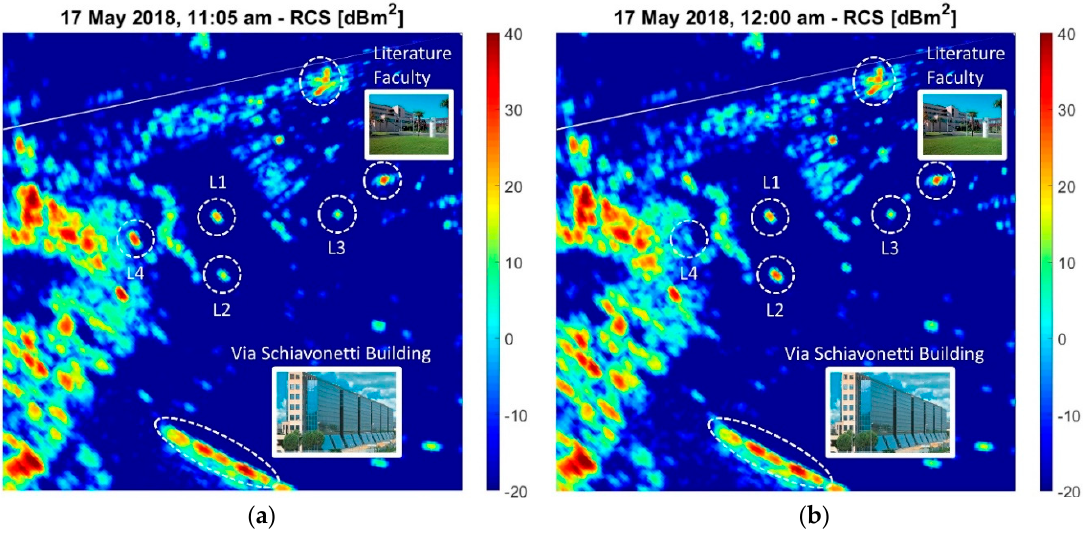
Figure 10. Measured RCS, 17 May 2018: ( a ) 11:05 and ( b ) 12:00.